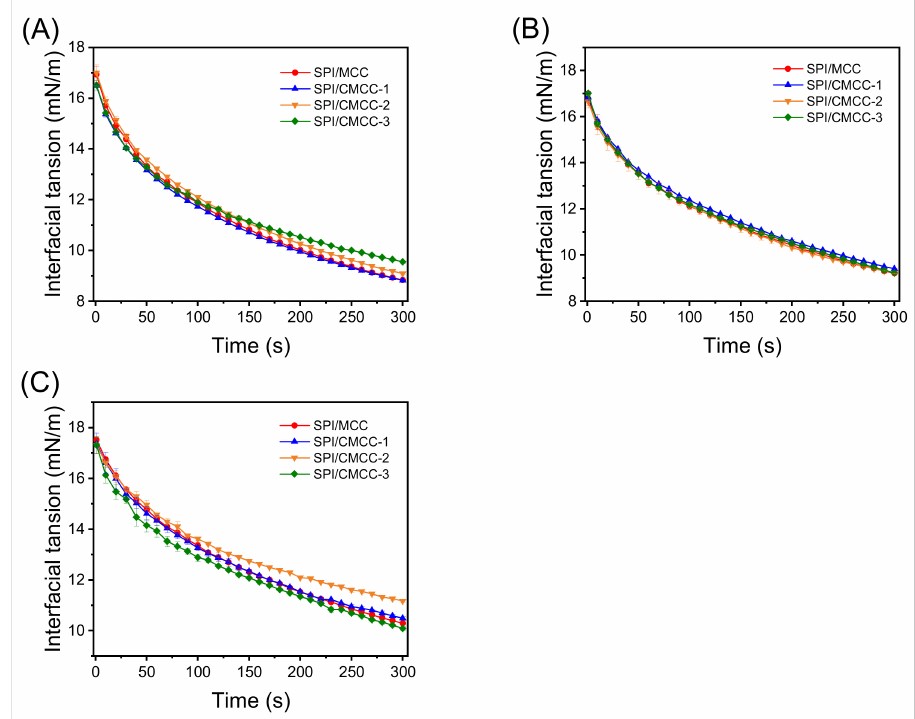
Figure 6. Interfacial tension of soybean oil/water interfaces as stabilized by complexes of SPI and MCC/CMCC at ratios of 3:1 ( A ), 1:1 ( B ), and 1:3 ( C